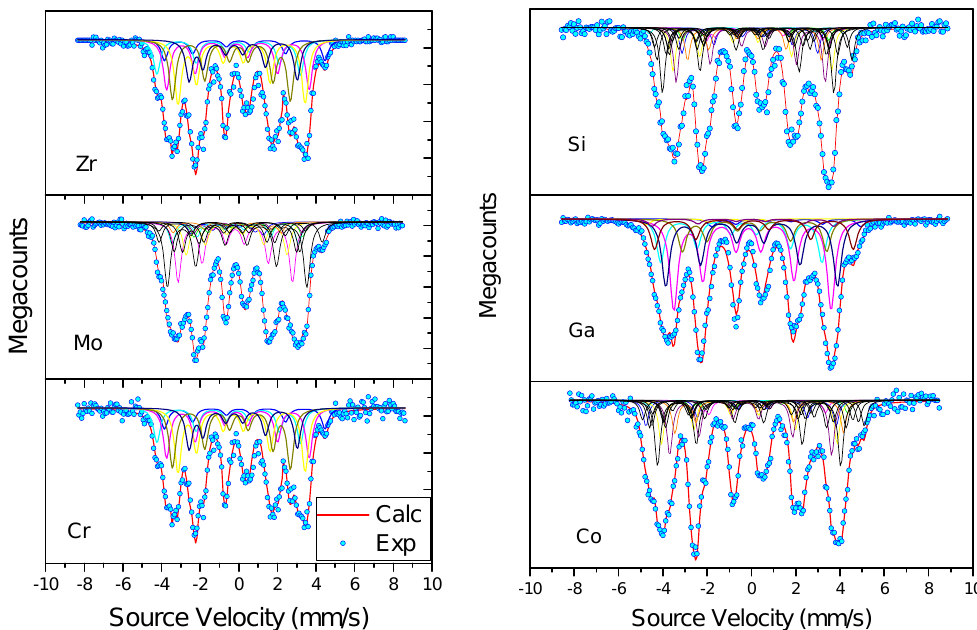
Figure 6. The room temperature Mössbauer spectra of Sm 2 Fe 16 M ( M = Zr, Mo, Cr, Si, Ga, Co) [28,30,75,96–98].